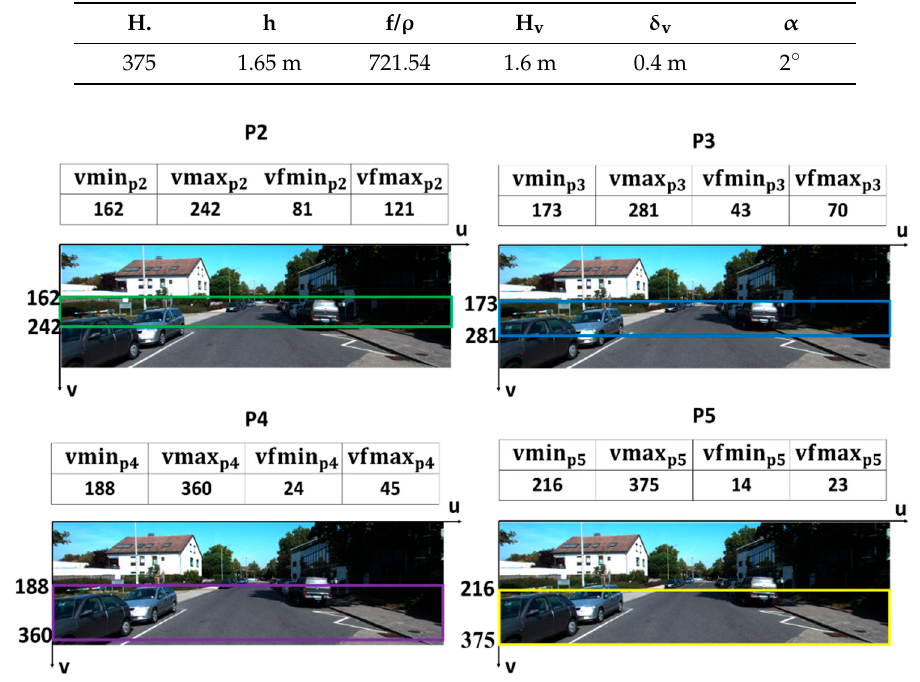
Table 2. Parameter values in this section.